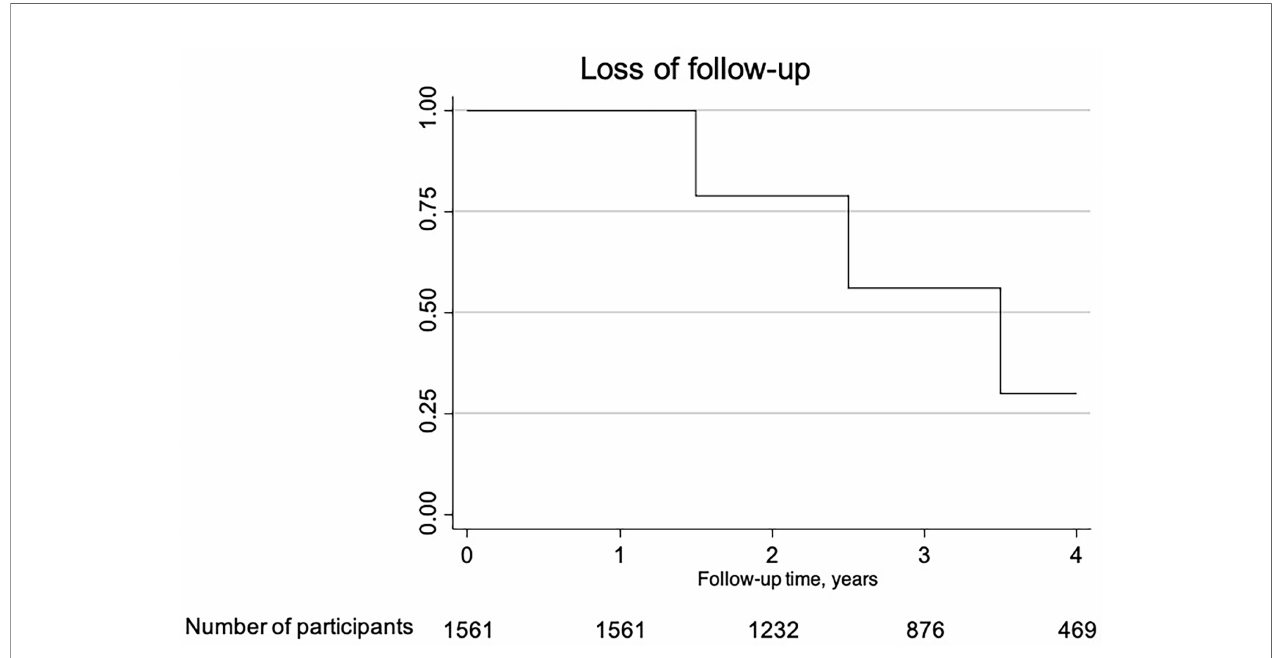
FIGURE 1 | Kaplan-Meier curve representative of the lost to follow-up along the time of the